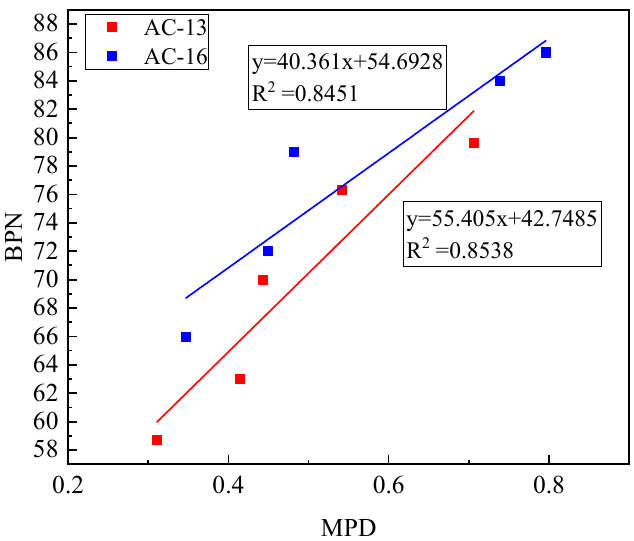
Figure 16. Relationship between BPN and MPD.